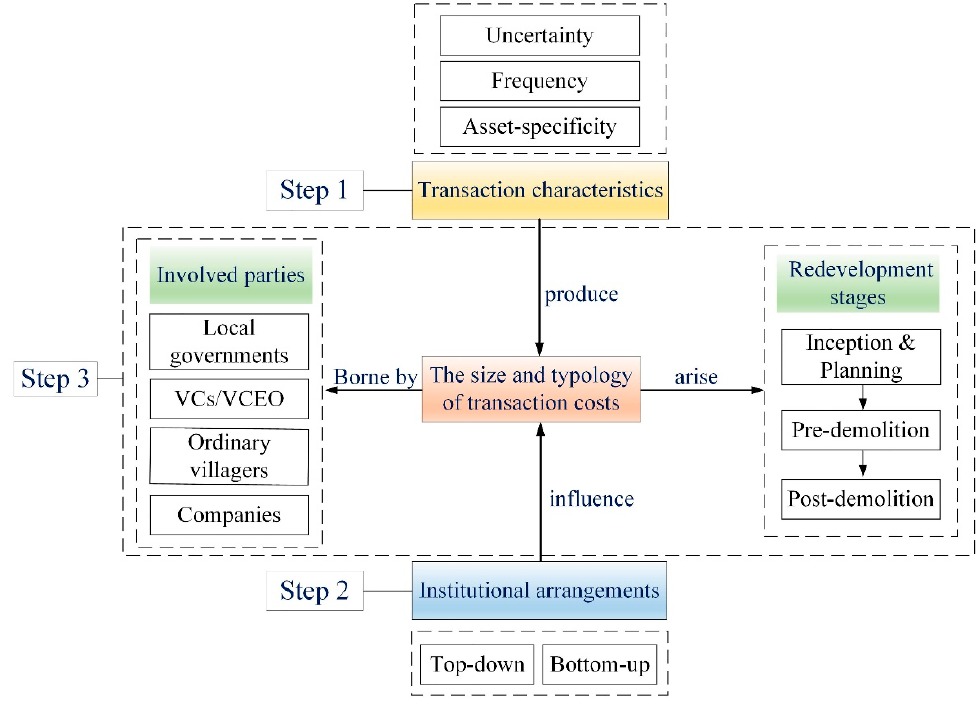
Figure 2. Analytical framework.